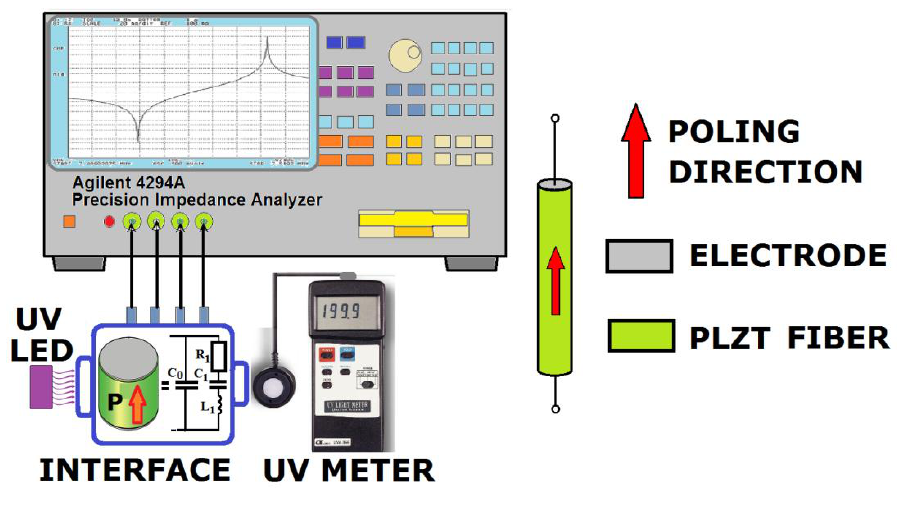
Figure 1. Measurement setup and electrical equivalent circuit of piezoelectric fiber resonator.